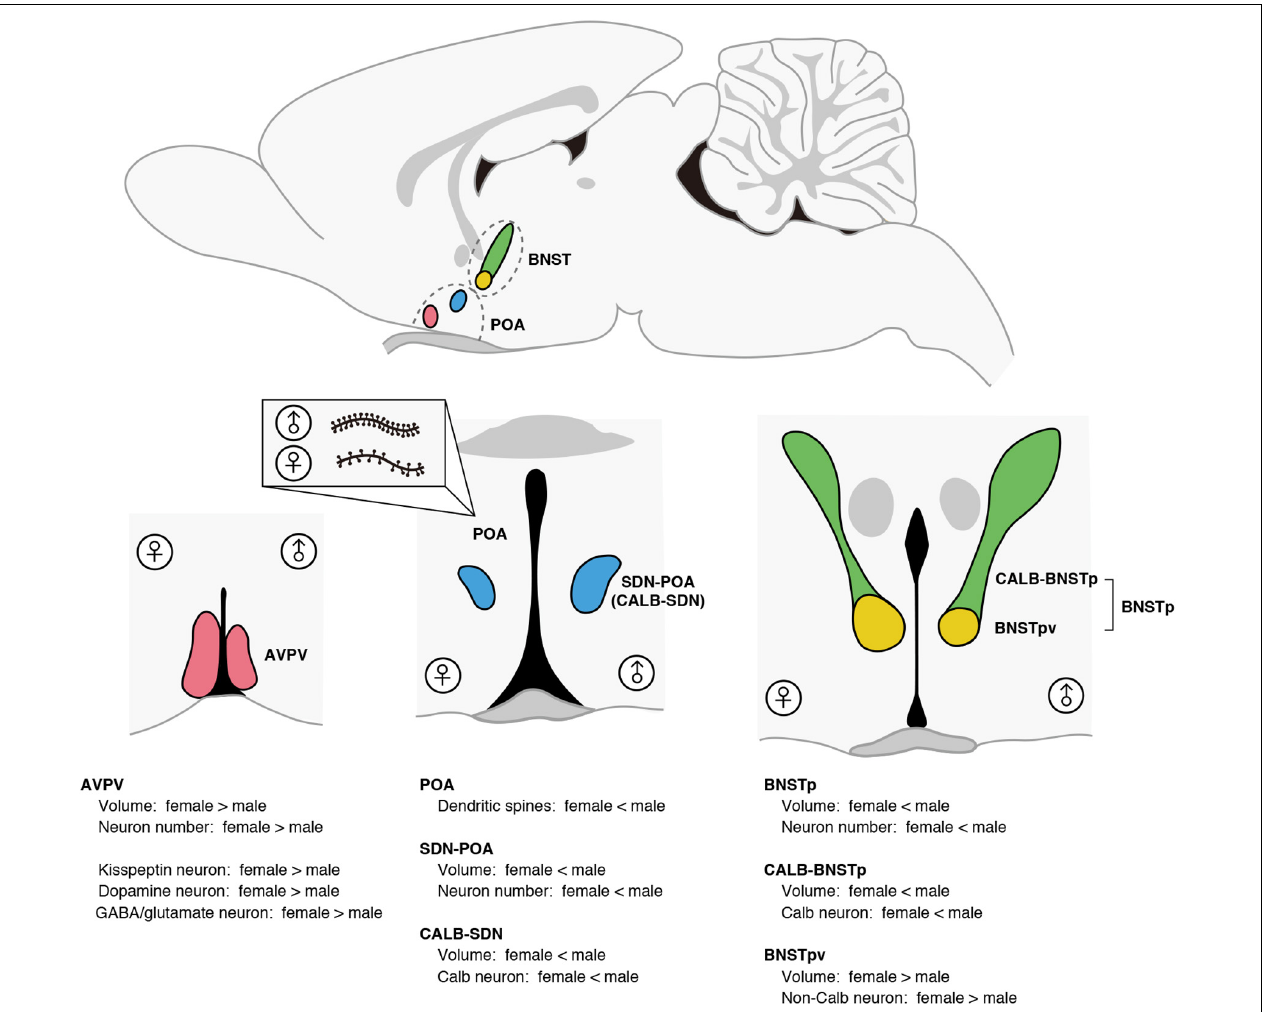
FIGURE 1 | Morphological sex differences in the POA and BNST of rats and mice. The AVPV exhibits female-biased sex differences in volume and neuron number. Compared with males, females have a greater number of kisspeptin neurons, dopamine neurons, and GABA/glutamate neurons in the AVPV. The SDN-POA exhibits male-biased sex differences in volume and neuron number. The SDN-POA contains a cluster of Calb neurons termed CALB-SDN. The CALB-SDN is larger in volume and contains a larger number of Calb neurons in males than in females. The POA shows a sex difference in the dendritic synapse pattern. POA neurons in males have more dendritic spines compared with POA neurons in females. The BNST contains a male-biased sexually dimorphic nucleus (BNSTp), which is composed of a sexually dimorphic subregion that is larger in volume and number of Calb neurons in males (CALB-BNSTp) and a sexually dimorphic subregion that is larger in volume and number of non-Calb neurons in females